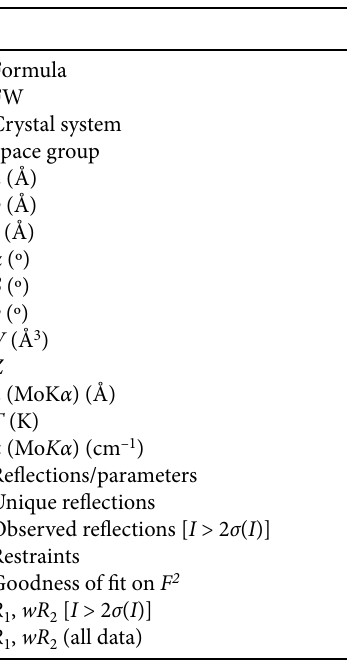
Table 1. Crystal data for HL and the